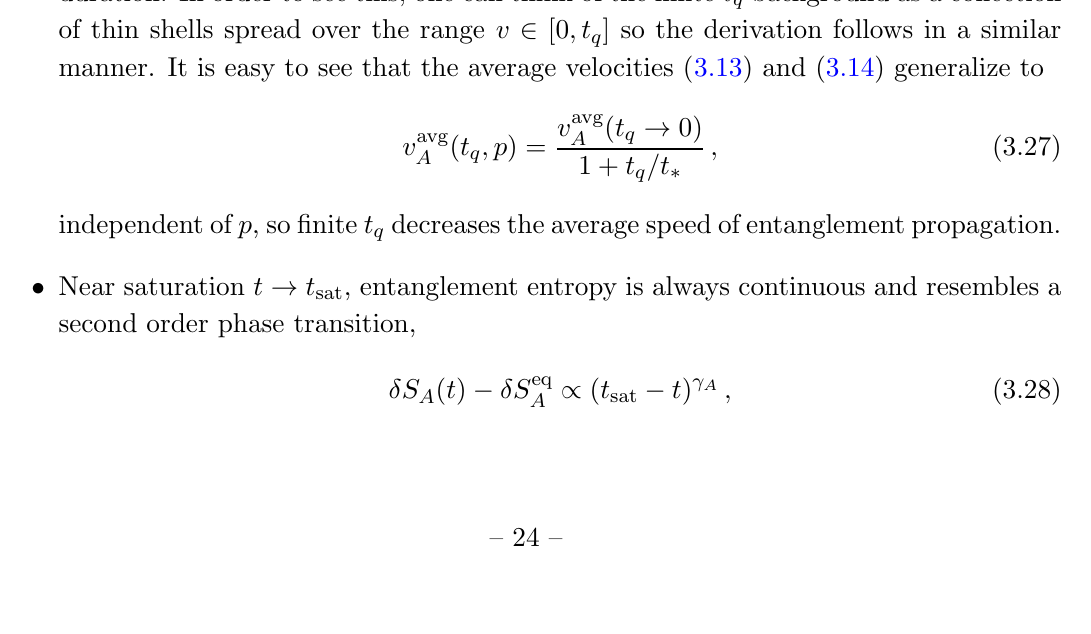
Figure 5 . Plots of entanglement entropy (cid:14)S dependent relative entropy (cid:7) A ( t ) for the ball, after a power-law quench with p = depicted in red, yellow, green and blue, respectively. For the plots we have (cid:12)xed the number of dimensions to d = 2 and we have chosen values t q =t plots, the dashed vertical line signals the end of the driven phase t = t q